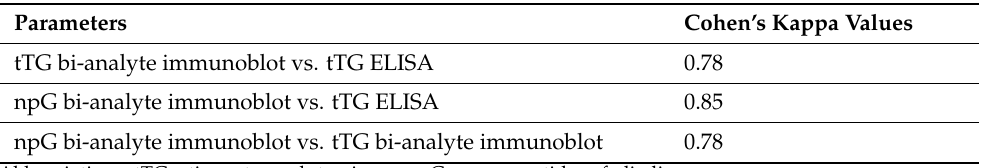
Table 4. Interrater agreements (Cohen’s kappa values) among examined immunoserological systems for the antibodies tested.